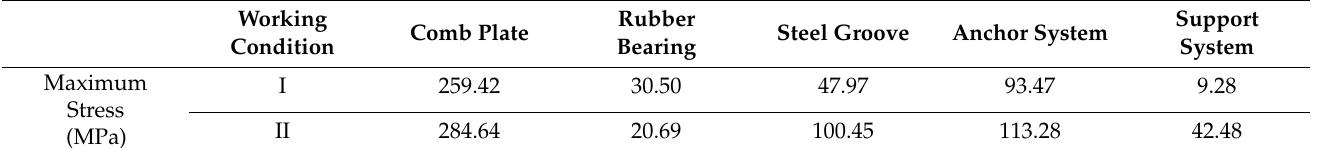
Figure 7. Equivalent stress diagram of the structure under working condition II.